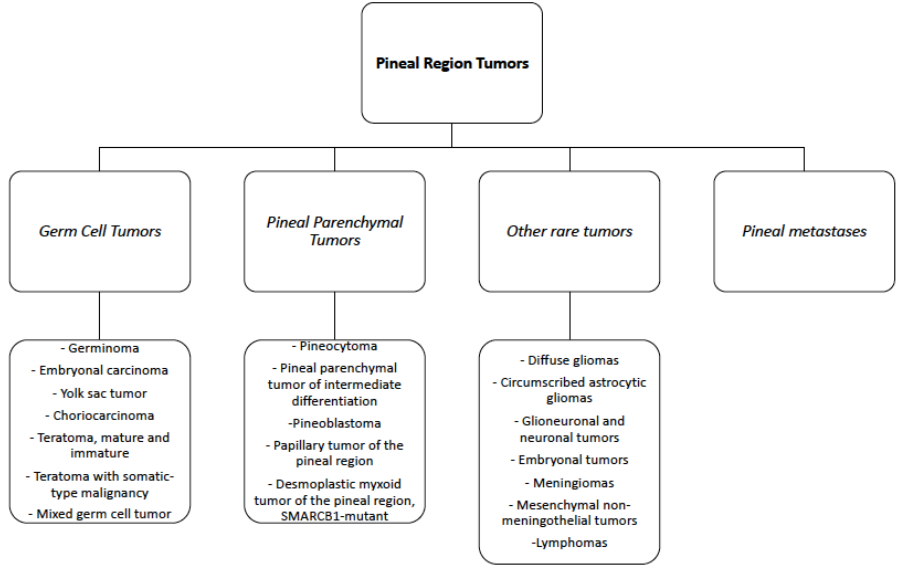
Figure 1. Summary of the Pineal Region Tumors according to the WHO 2021 classification.